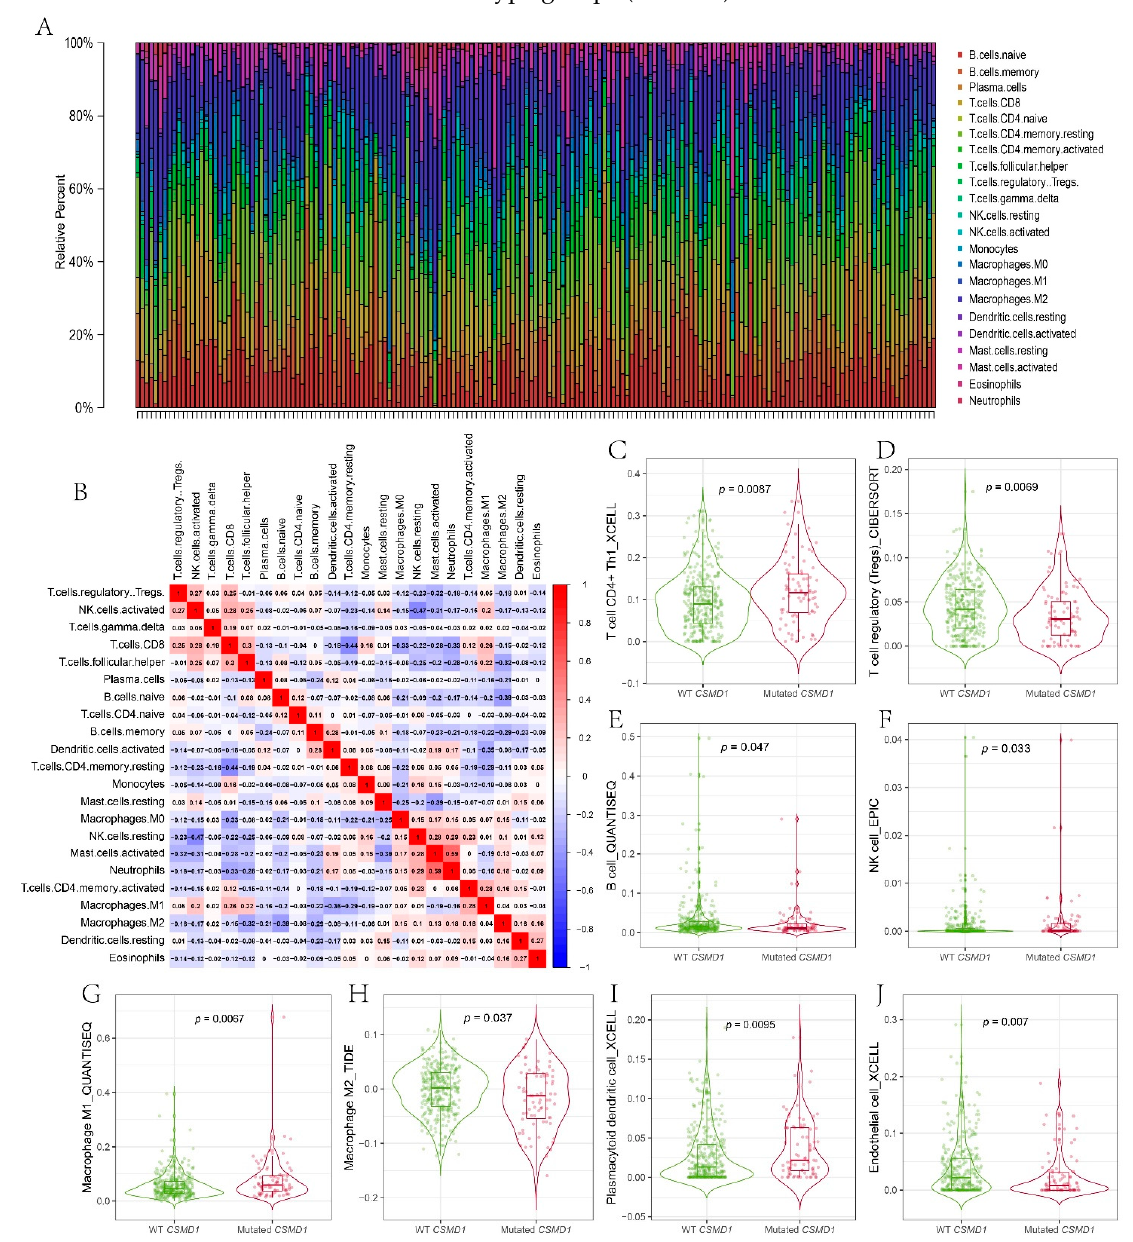
Figure 5. Immune infiltration. ( A ) The proportion of 22 kinds of immune cells in 437 gastric cancer samples. ( B ) The matrix of correlation between immune cells. Infiltration associated with anti-tumor immunity; ( C ) CD4+ Th1 cells, ( F ) NK cells, ( G ) M1 macrophage cells and ( I ) PDC. Infiltration associated with promoting tumor immunity ( D ) Treg cells, ( H ) M2 macrophage cells and ( J ) endothelial cells. ( E ) B cells. Figure 5C–J were from TIMER2.0 website. Wilcoxon test for